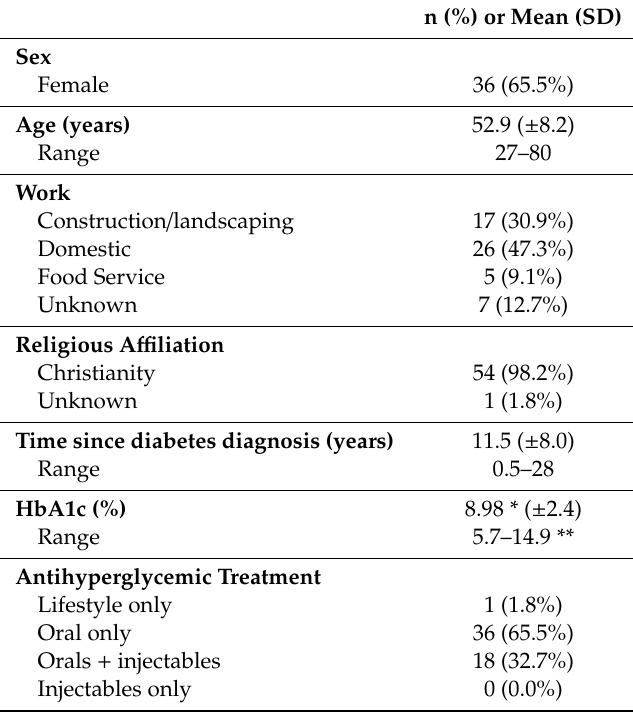
Table 1. Baseline Participant Characteristics (n =